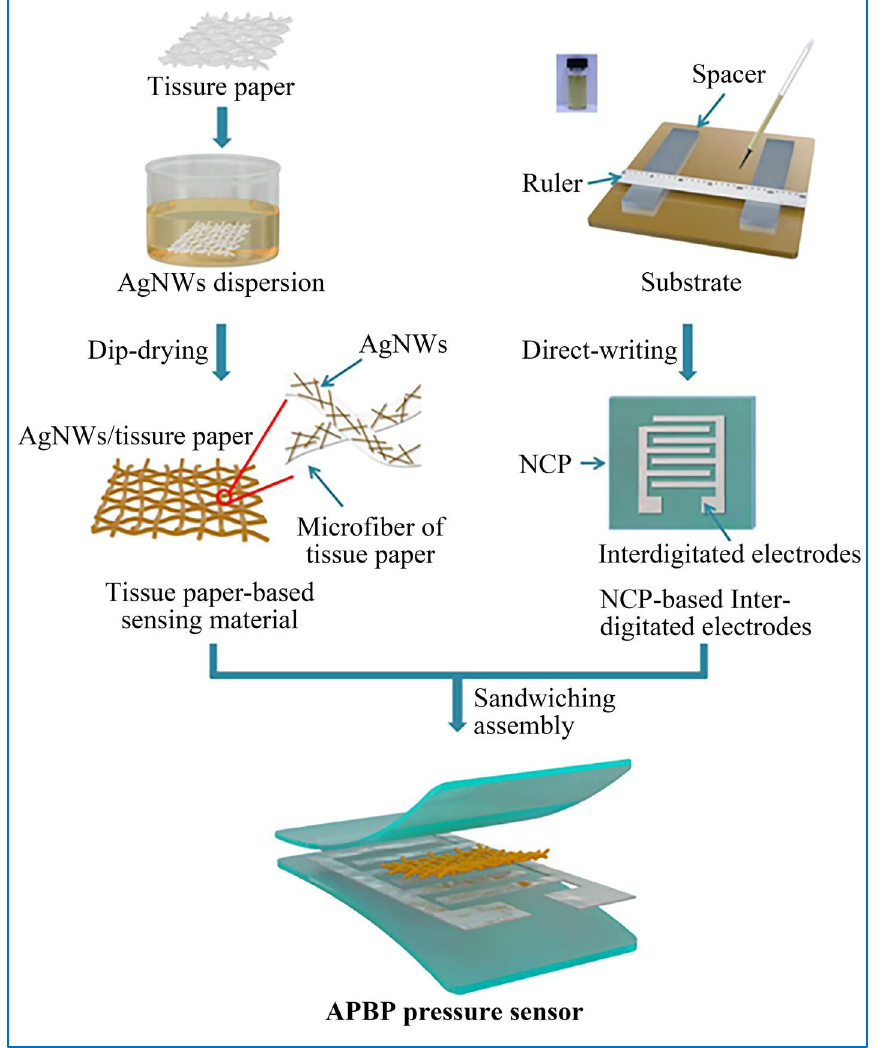
Figure 11. Schematic of preparation process of an all paper-based flexible and wearable piezoresistive pressure sensor [169].